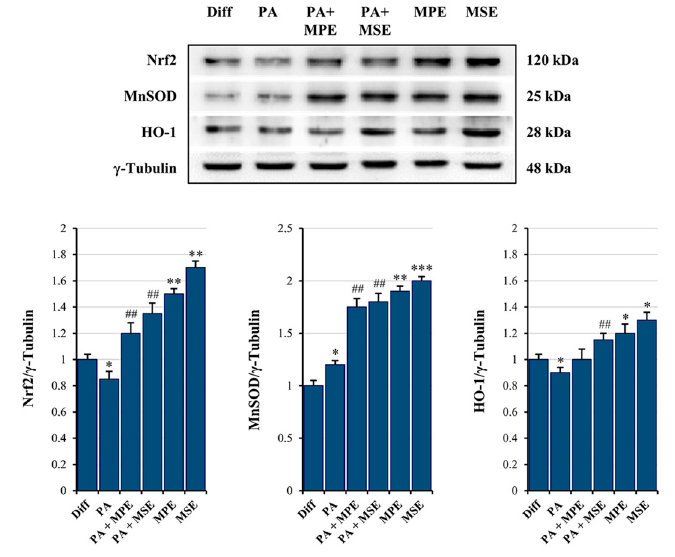
Figure 8. MPE and MSE increase the expression levels of the anti-oxidant molecules. Differentiated 3T3-L1 adipocytes were treated with 500 µM PA for 48 h in the presence or absence of 100 µg/mL MPE or MSE. Cell lysates underwent Western blotting analysis for Nrf2, MnSOD and HO-1. An equal loading (30 µ g) of proteins was verified by immunoblotting for γ -Tubulin. The bar graphs represent the means of three independent experiments ± SD. The statistical differences between groups were evaluated using a one-way ANOVA test. * p < 0.05, ** p < 0.01 and *** p < 0.001 were significant with respect to differentiated 3T3-L1 adipocytes. ## p < 0.01 was significant with respect to PA-treated differentiated 3T3-L1